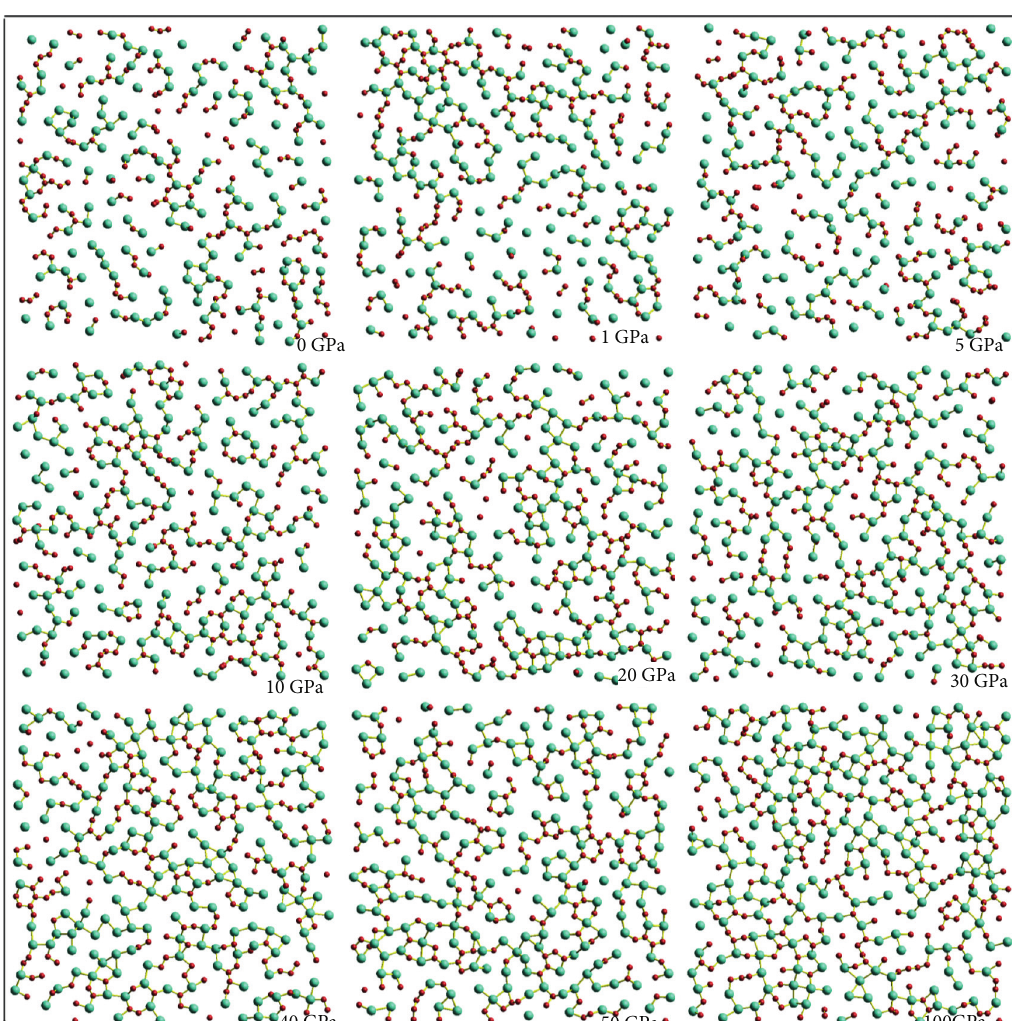
Figure 11: Partial cross-section of amorphous SiC after solidification under different pressures and at 100K (thickness of 1.5 atomic